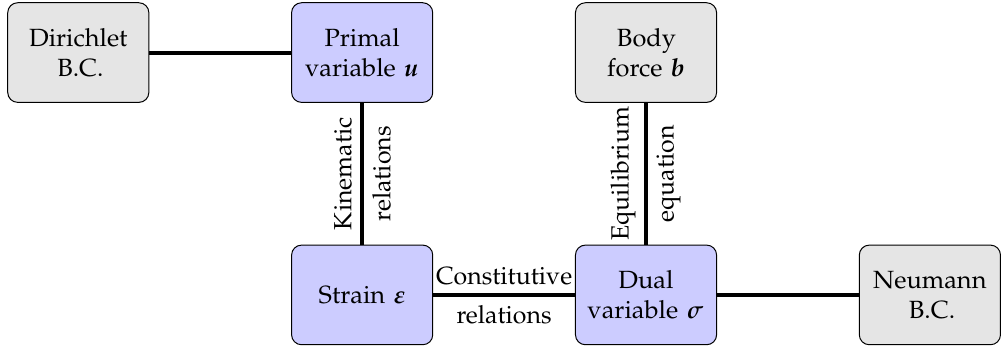
Figure 1. Graphical representation of the strong form of a structural problem (Tonti